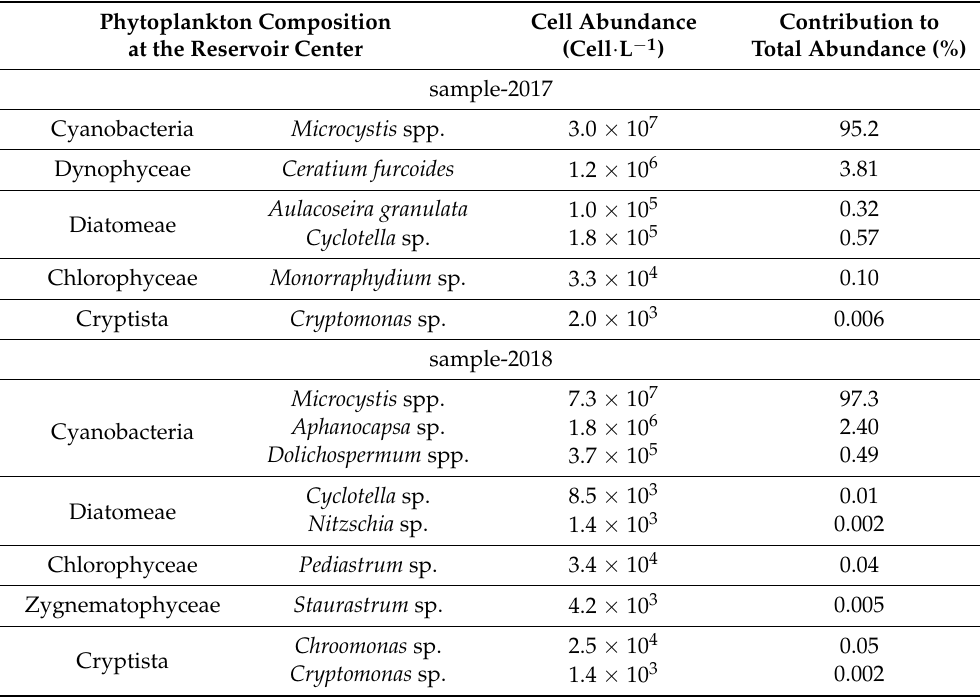
Table 2. Characterization of phytoplankton community during Microcystis spp. bloom collected for microcosm experiments in March 2017 (sample-2017) and February 2018